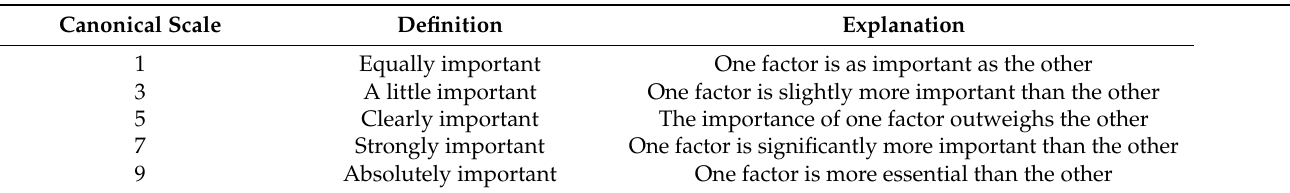
Table 6. Decision table of index rating decision data.